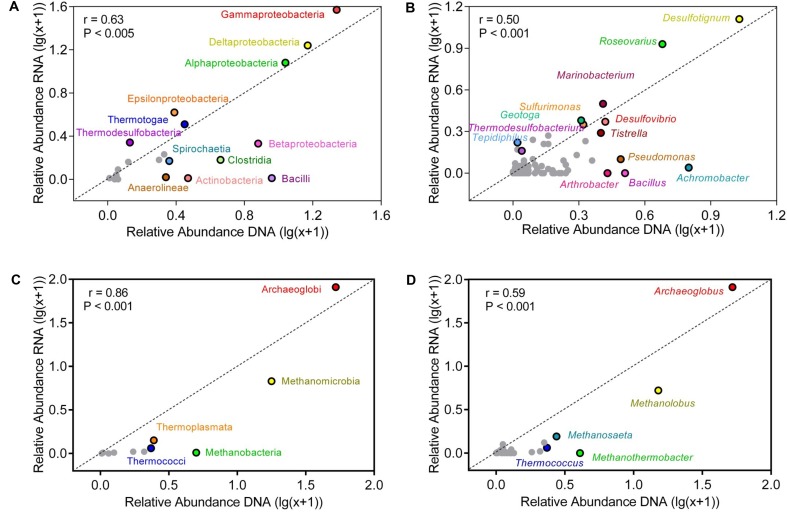
Correlation of relative abundances of taxa in bulk and active microbial communities at class (A,C) and genus (B,D) level. (A,B) represent bacterial communities (C,D) represent archaeal communities. The abundance shown was averaged across all samples. Relative abundances were log-transformed to reduce skewness of the data. Points above the diagonal indicated those taxa enriched in the RNA amplicon libraries. Gray points indicate taxa, which occurred in low numbers.